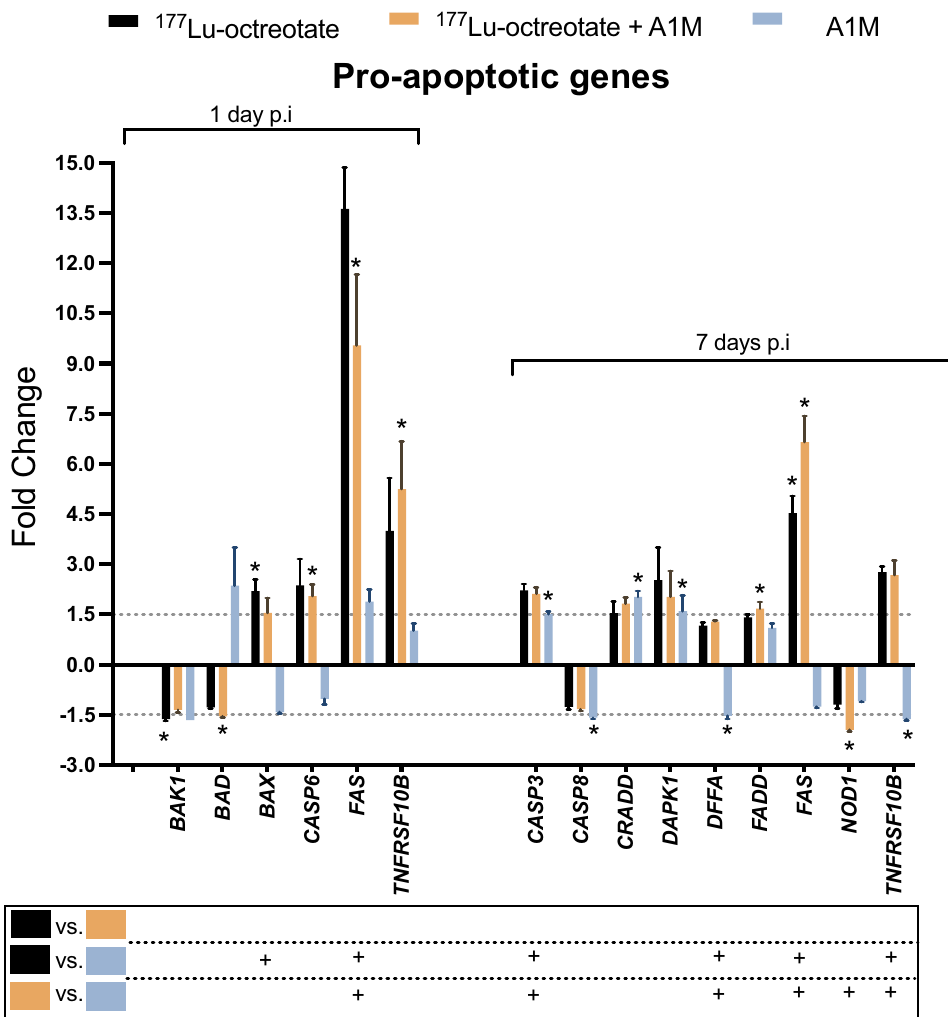
Figure 2. Pro-apoptotic response in GOT1 tumors after exposure to 177 Lu-octreotate, 177 Lu-octreotate + A1M, and A1M alone. The figure shows expression of all pro-apoptotic genes with significantly different expression compared to controls (p < 0.05 and regulated |FC|≥ 1.5) in at least one of the three groups. Dashed lines represent |FC|= 1.5, and the box beneath the graph shows results from group comparisons from one-way ANOVA tests, where “+” represents a statistically significant difference (p < 0.05) between groups. Tumors from three and two mice were used in the treatment and control group, respectively, with an exception for DAPK1 in A1M only group (n = 2). Error bars represent SEM. *p < 0.05 (0.0010–0.050). Statistical analysis was performed using Perseus software 1.6.15.0 (https:// maxqu ant. net/ perse us/) and the figure was produced using GraphPad Prism version 9.3.1 (https:// www. graph pad. com/ scien tific- softw are/